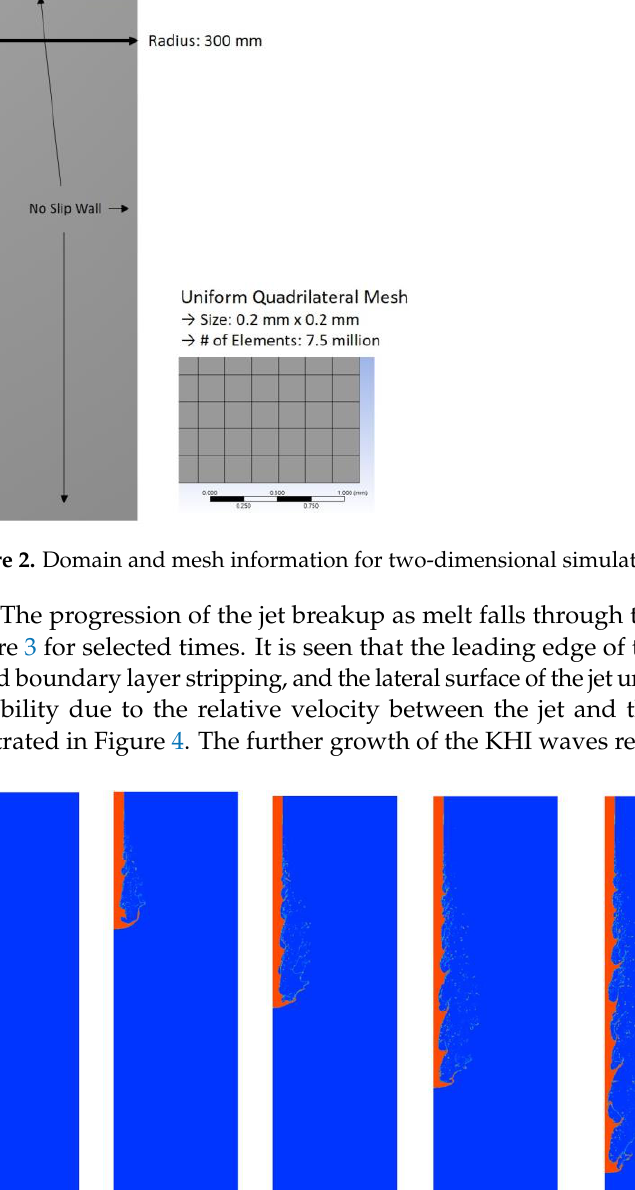
Figure 4. Illustration of jet breakup by KHI and BLS. Figure 5. Five sections and image analysis for particle size distributions.